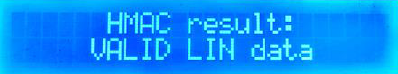
Figure 16. Master node’s first HMAC display.